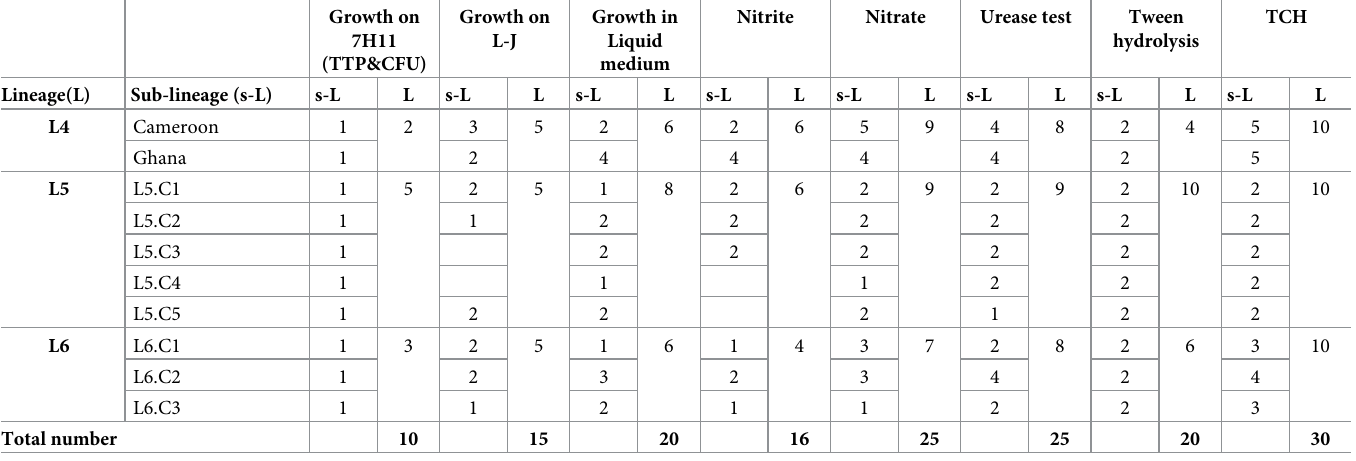
Table 1. Mycobacterial isolates (lineages/sub-lineages) used for each experiment.